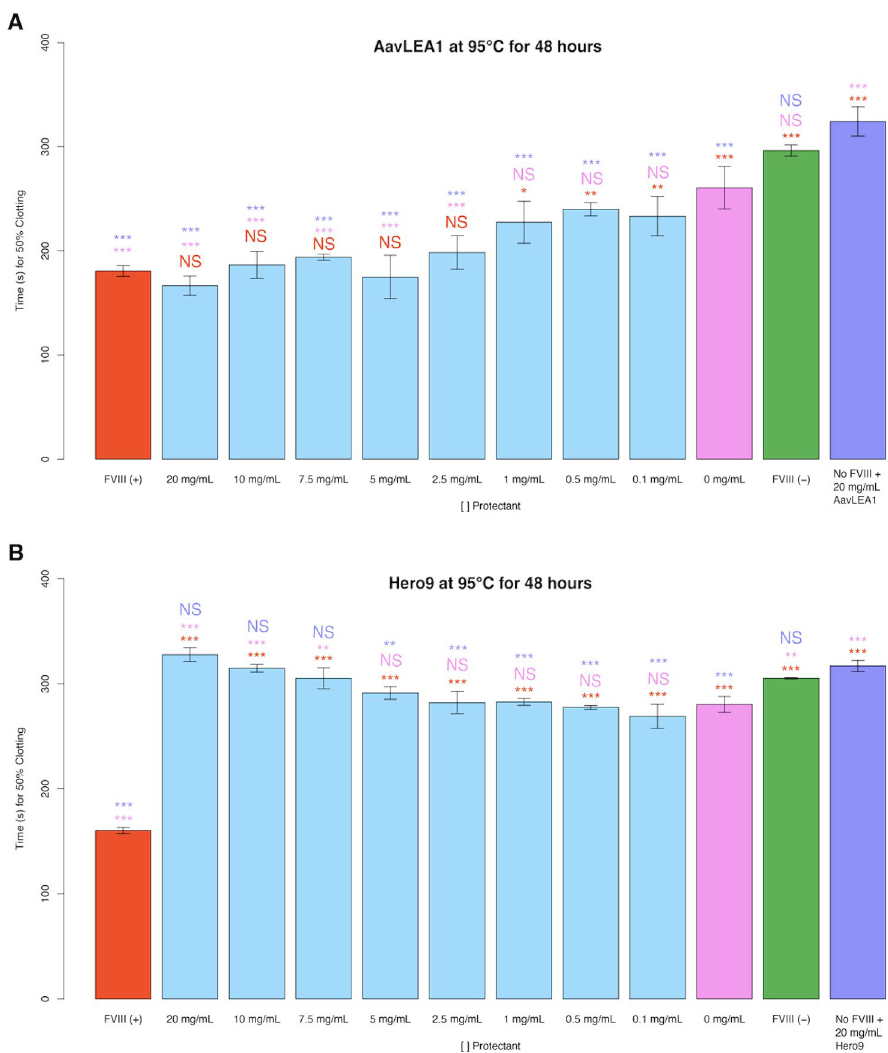
Figure 7. Using AavLEA1 or Hero9 as potential stabilizers of FVIII under thermal stress. Histogram representation of the 50% clotting time of FVIII treated with ( A ) AavLEA1, ( B ) Hero9. The red “FVIII (+)” bar represents FVIII deficient human blood plasma treated with unperturbed FVIII. All red notations above sample bars represent statistical comparison with “FVIII (+).” “X mg/mL” notations beneath sample bars correspond to the concentrations of AavLEA1 or Hero9 mixed with FVIII before desiccation. All pink notations above sample bars represent statistical comparison with “0 mg/mL.” The green “FVIII (−)” bar represents FVIII deficient human blood plasma treated with no FVIII. “No FVIII + X mg/mL AavLEA1 or Hero9” represents FVIII deficient human blood plasma treated with X mg/mL AavLEA1 or Hero9 but no FVIII. All purple notations above sample bars represent statistical comparison with “No FVIII + X mg/mL, AavLEA1, or Hero9.” Notations above sample bars represent statistical significance determined by one-way ANOVA and Tukey’s post- hoc test. Error bars represent bi-directional standard deviation. P value > 0.05 = NS, P < 0.05 = *, P < 0.01 = **, P < 0.001 =